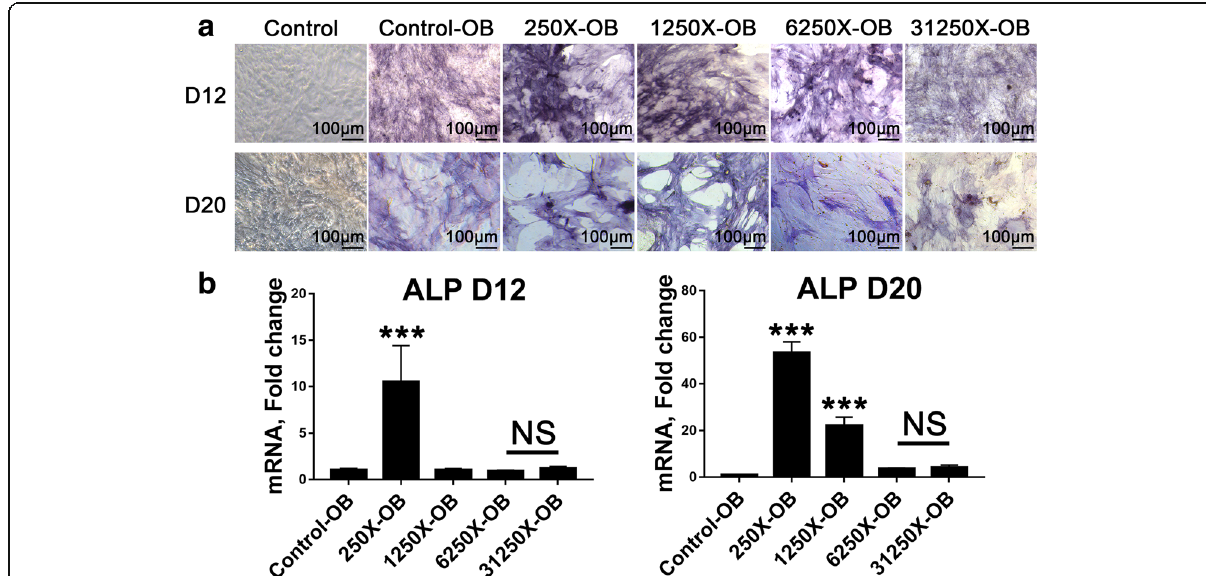
Fig. 3 Effect of different concentrations of Osteoking on alkaline phosphatase expression in rbMSCs. a Alkaline phosphatase (ALP) staining of rat bone marrow mesenchymal stem cells (rbMSCs) cultured in mesenchymal stem cell (MSC) medium or osteoblast maturation medium with different concentrations of Osteoking after 12 and 20days. D=day, X=dilution multiple of Osteoking. b Gene expression analysis for ALP of rbMSCs cultured in osteoblast maturation medium with different concentrations of Osteoking after 12 and 20days by qRT-PCR., *** p <0.001 vs. control; n =5